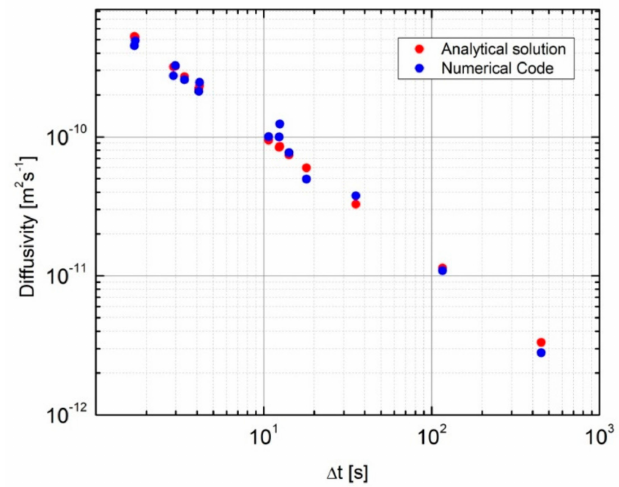
Figure 7. Comparison between the results obtained with the numerical code and those of the analytical solution of the dimensional